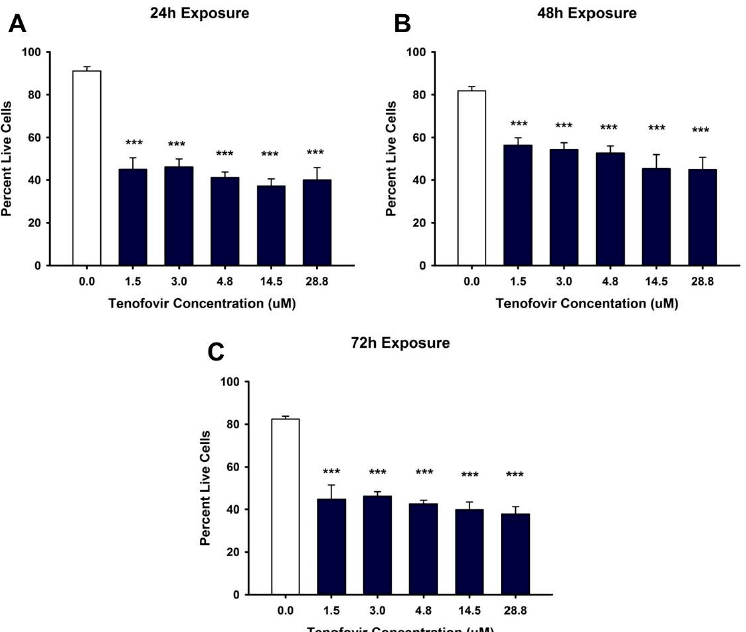
Figure 2. Tenofovir cytotoxic effects on cell viability in HK-2 cells using Trypan Blue Exclusion. Tenofovir diminished cell viability at 24 ( A ), 48 ( B ) and 72 h ( C ). Statistical difference from 0 μ M tenofovir is denoted by asterisks (*** p < 0.001). Each bar represents Mean ± SEM for three independent experiments run with two biological replicates.